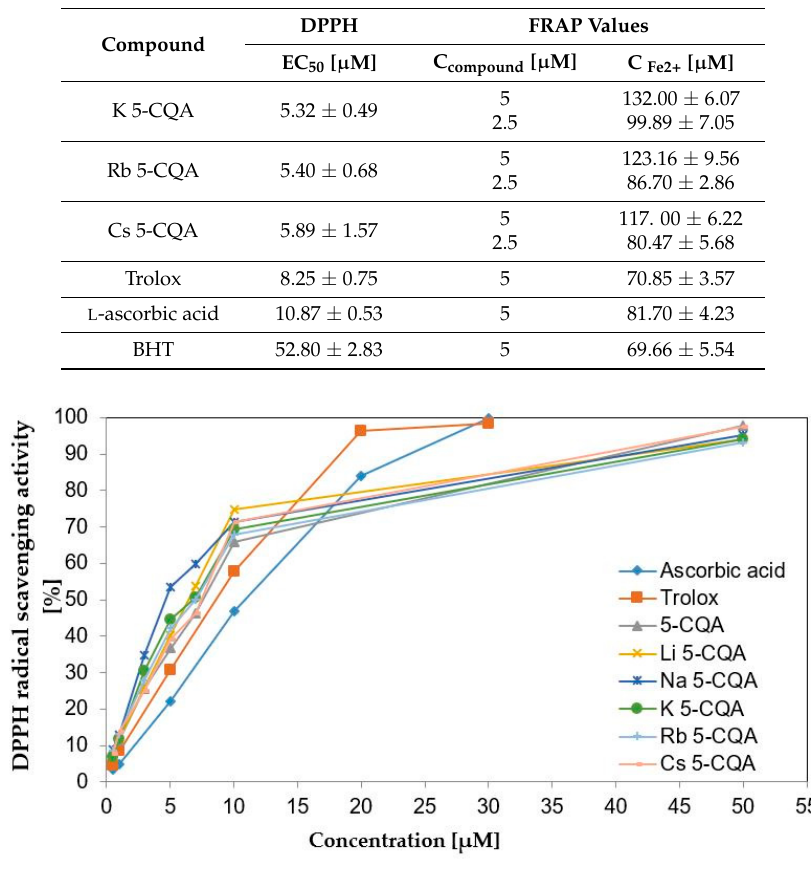
Figure 2. DPPH ( α , α -diphenyl- β -picrylhydrazyl) radical scavenging activity (%) of chlorogenic acid, chlorogenates, trolox and ascorbic acid.